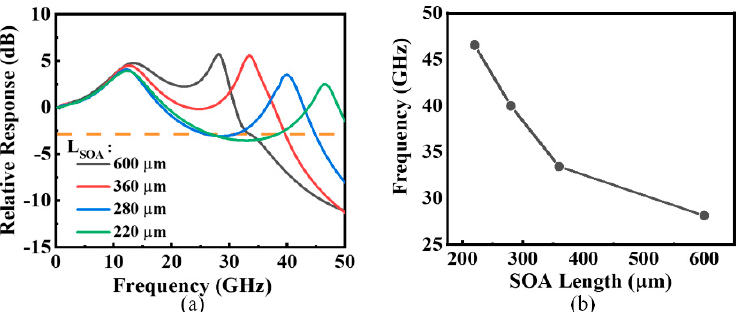
Figure 3. ( a ) Simulated small-signal modulated response of the IMC laser with different semiconductor optical amplifier (SOA) lengths. ( b ) The dependence of the photon–photon resonance (PPR) frequency on the SOA length. The SOA length was varied from 220 to 600 μ m, and the distributed feedback (DFB) length was fixed at 220 μ m. I DFB1 was fixed at 100 mA, while I SOA and I DFB2 were adjusted to ensure that the device would work under the mutual injection-locking (MIL) state with a similar suitable side-mode suppression ratio (SMSR).